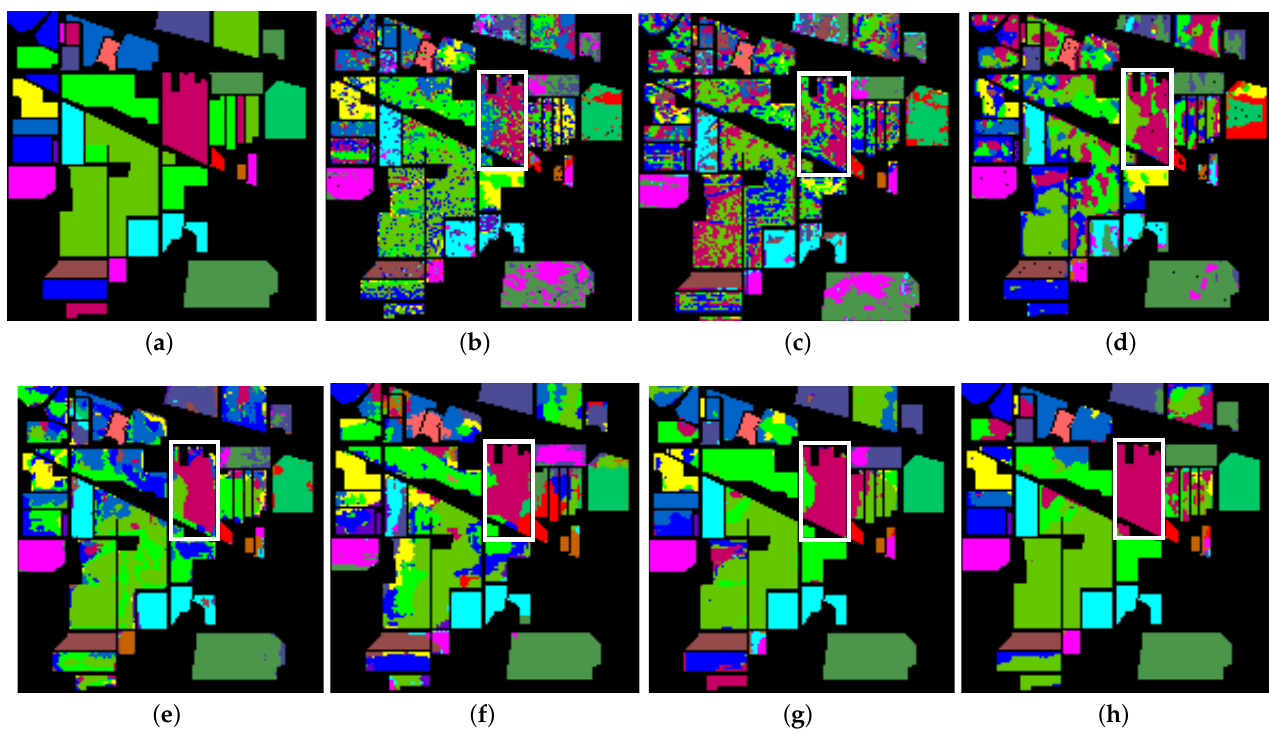
Figure 7. Graph of classification results of IP dataset. The highlighted white box in each subfigure is to compare the classification results more clearly. ( a ) Ground truth (GT). ( b ) SVM. ( c )